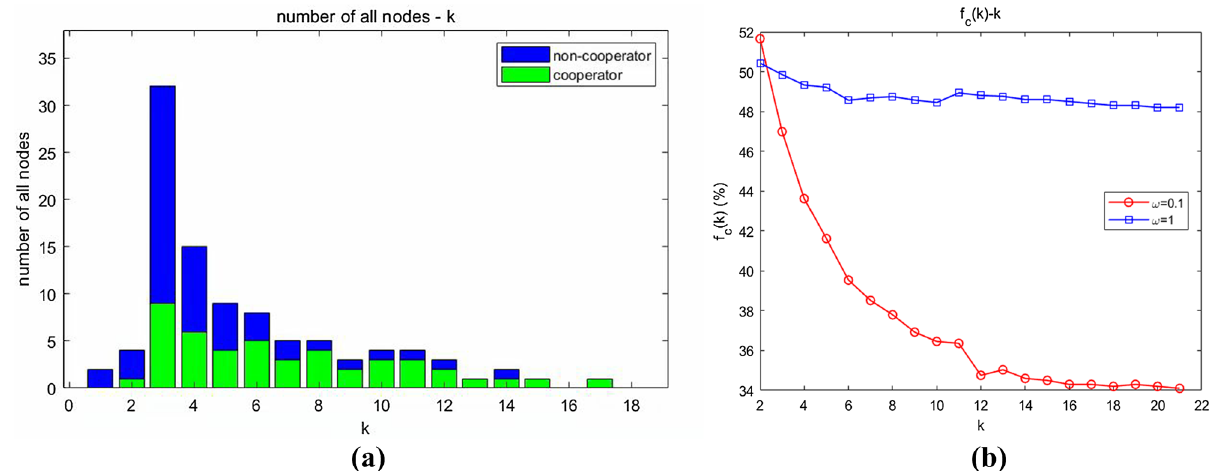
Figure 8. Degree distribution and dependence of the emergence of collaboration on degree. ( a ) Degree distribution in a single calculation; ( b ) dependence of the emergence of collaboration on